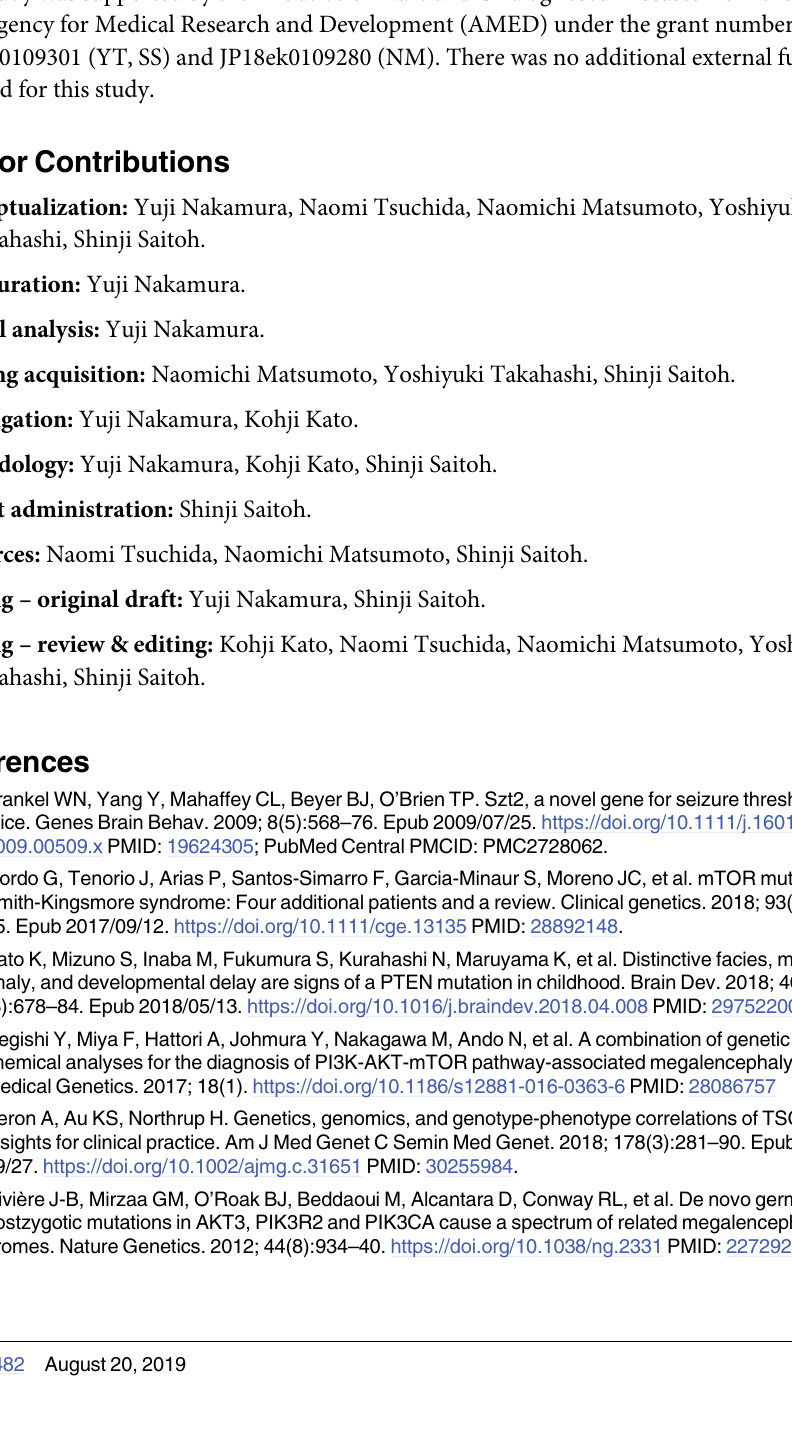
S1 Fig. Constitutive lysosomal localization of mTOR in the patient 2. Representative images of co-localization of mTOR (red) and LAMP1 (green) in patient 2, wild type 2 and 3. Right panels show the enlarged view of co-localizing area. DAPI, nuclear staining (blue). Scale bars, 5 μ m.